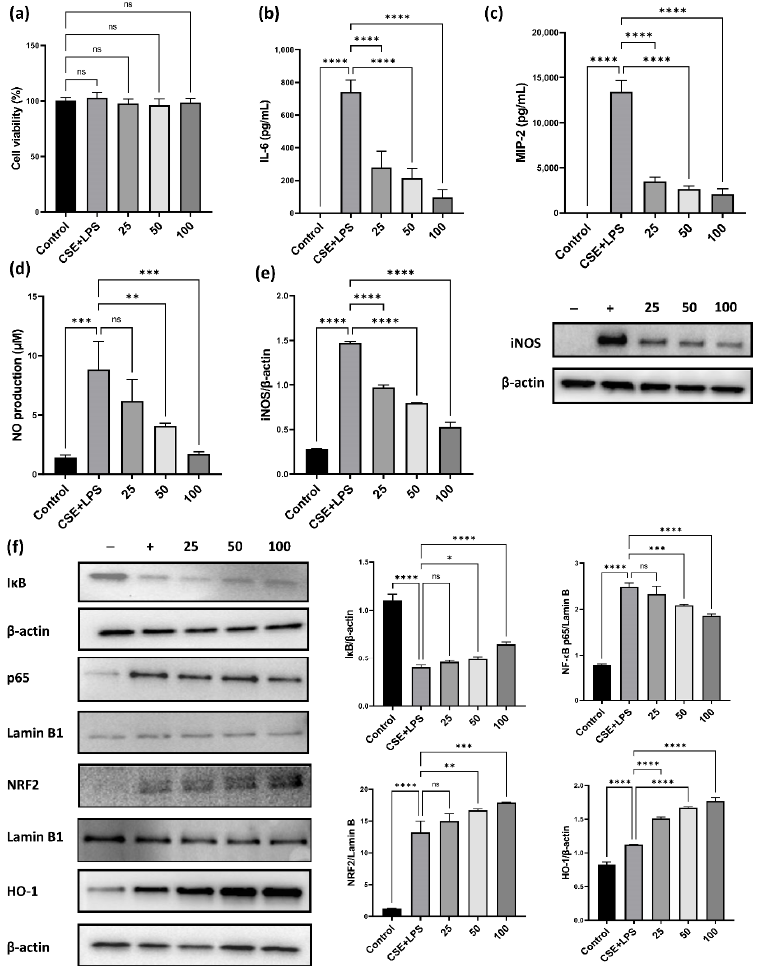
Figure 5. Effect of the CLE on cell viability and the production of cytokines, NO and the activation of NF- κ B and NRF2 pathways in MH-S macrophages. For the cell viability assay, ( a ) the MH-S macrophages were co-treated with 25, 50, 100 µ g/mL of CLE and 1% CSE and 10 ng/mL LPS for 24 h. Cell viability was estimated by the WST assay. Then, IL-6 ( b ) and MIP-2 ( c ) in the culture supernatants were quantified using ELISA assays. NO production levels ( d ) were determined using Griess assay. ( e , f ) Protein expression levels of iNOS, I κ B, NF- κ B p65, NRF2, HO-1, β -actin, and Lamin B1 were visualized using Western blots. Data were analyzed by one-way ANOVA using Dunnett’s test. All values are reported as mean SD. * p < 0.05, ** p < 0.01, *** p < 0.001, **** p < 0.0001. CLE: Camellia sinensis L. extract, NO: Nitric oxide, NF- κ B: Nuclear factor- κ B, NRF2: Nuclear factor-E2-related factor 2, CSE: Cigarette smoke extract, LPS: Lipopolysaccharide, IL-6: Interleukin 6, MIP-2: Macrophage inflammatory protein-2, iNOS: Inducible nitric oxide synthase, HO-1: Heme